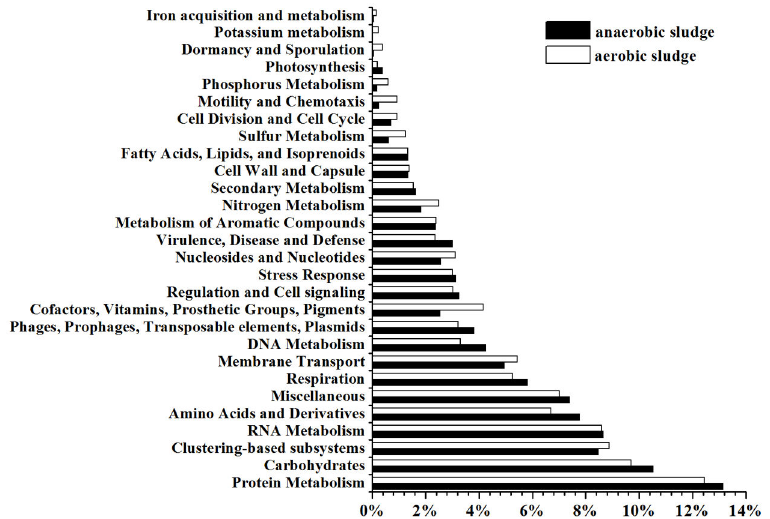
Figure 2. Relative distribution of sequencing reads in major level 1 subsystems in anaerobic and aerobic sludge. Metagenomic data were annotated against SEED subsystems in MG-RAST at a cutoff of E-value < 10 -5 . doi: